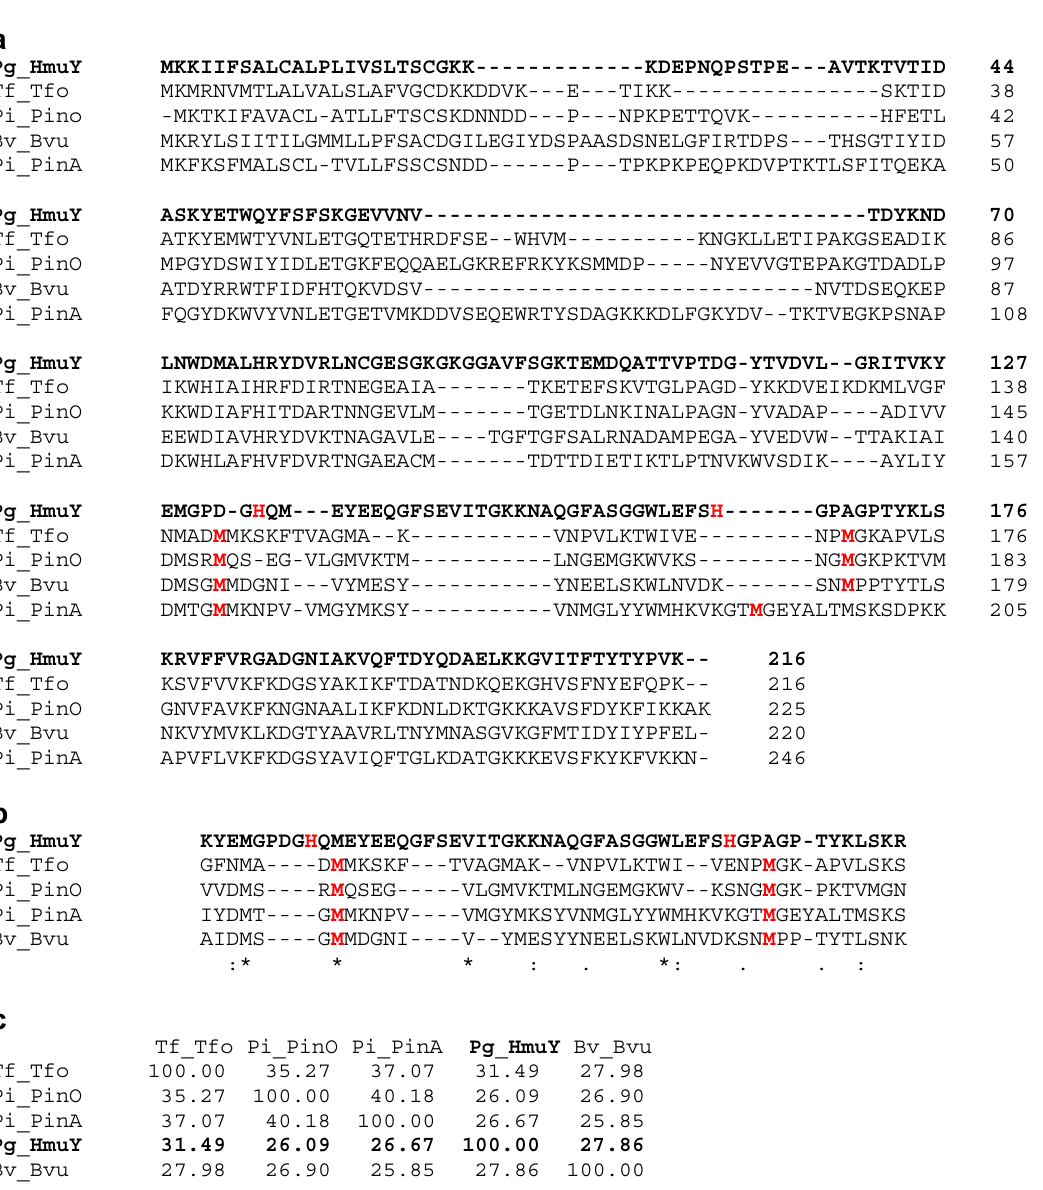
Figure 1. Comparison of best-characterized HmuY family proteins. ( a ) Amino acid sequence align- ment of full-length proteins, ( b ) their regions comprising heme-binding site, and ( c ) determination of amino acid sequence identity, carried out using EMBL-EBI Clustal Omega tool [33]. Data obtained for HmuY shown in bold. Amino acid residues coordinating heme iron, identified by site-directed mutagenesis, shown in red. Tf, T. forsythia ; Pi, P. intermedia ; Pg, P. gingivalis ; Bv, B. vulgatus .